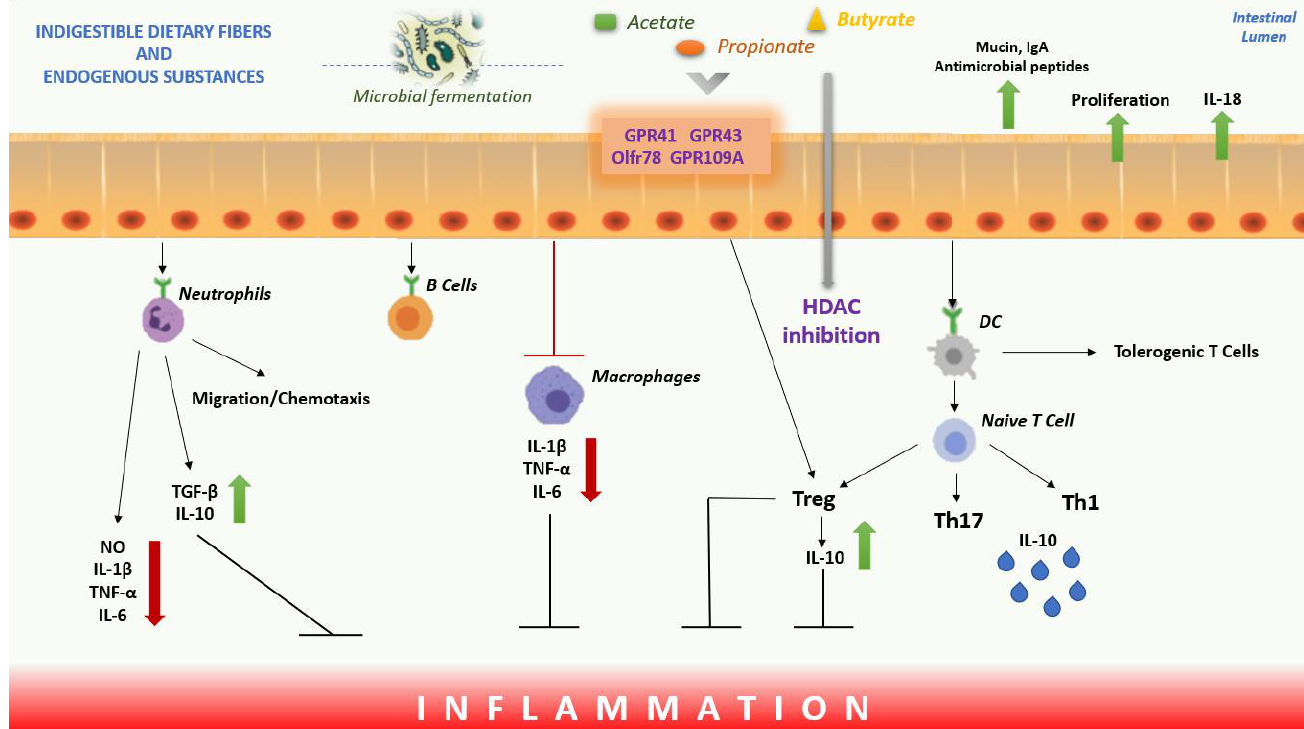
Figure 1. Overview of the effect of the SCFAs on inflammation. In the intestinal lumen, SCFAs induce the secretion of IL-18, MUC2 and antimicrobial peptides from intestinal epithelial cells, induce IgA secretion from B lymphocytes and regulate tight junction expression. SCFAs bind to GPR41, GPR43, GPR109A receptors and activate Olfr78 receptor signalling to regulate T cell function increasing the generation of Th1 and Th17 cells and promoting the production of T cells that release IL-10 and T regs. SCFAs act on DCs to limit the expression of T cells activating molecules, resulting in the generation of tolerogenic T cells rather than inflammatory T-cells. SCFAs also reduce neutrophil recruitment, with increased levels of TGF- β, IL -10 and decreased levels of IL-6, IL- 1β , NO, and TNF- α. Instead, through HDAC inhibition , they influence the inhibition of nuclear factor NF- κB, to inhibit inflammation. Abbreviations: DCs, Dendritic Cells; SCFAs, Short-chain Fatty Acids; GPCRs, G-Protein-coupled Receptors; HDAC, Histone Decetylase; NO, Nitric Oxide; TGF- β, Transforming Growth Factor beta; TNF- α, Tumor Necrosis Factor alpha; IL, Interleukin; Mucin, MUC2; NF - κB , Nuclear Factor Kappa-light-chain-enhancer of Activated B cells.